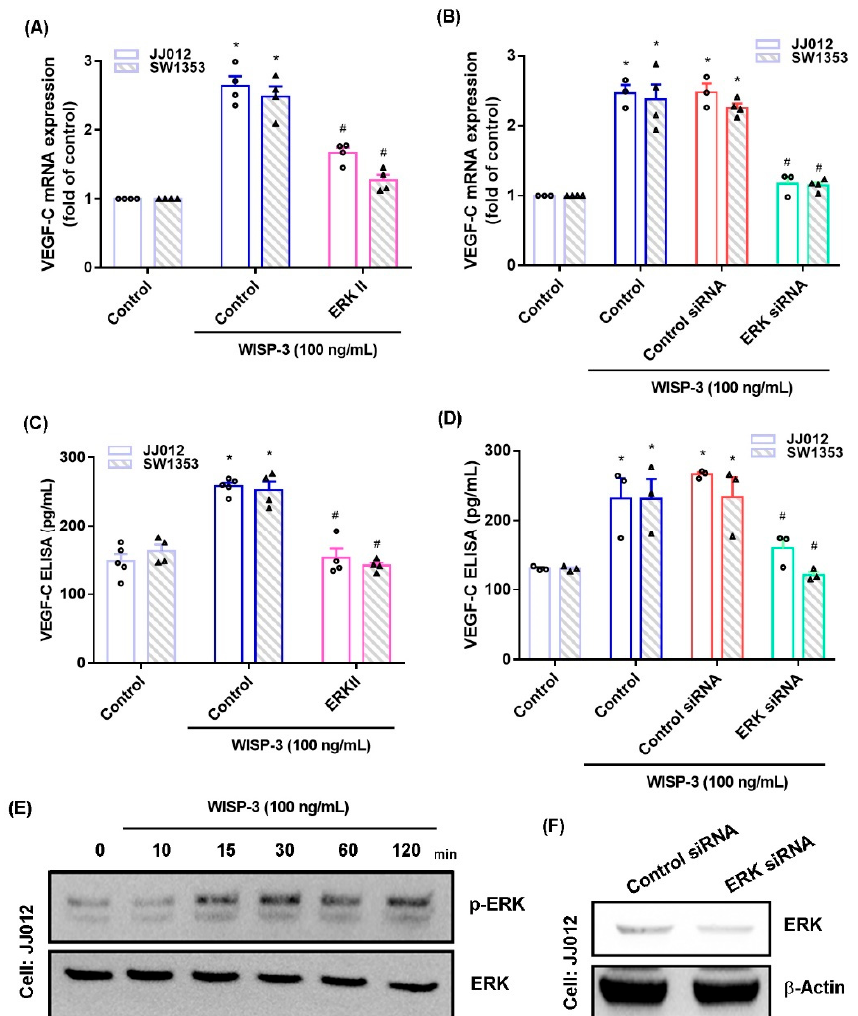
Figure 2. The ERK pathway controls WISP-3-induced VEGF-C production. ( A – D ) Cells were pretreated with a ERK inhibitor (ERK II) or transfected with an ERK siRNA, then stimulated with WISP-3. Levels of VEGF-C expression were examined by qPCR and ELISA. ( E ) JJ012 cells were incubated with WISP-3 for the indicated time intervals, and ERK phosphorylation was examined by Western blot. ( F ) JJ012 cells were transfected with ERK siRNA, and ERK expression was examined by Western blot. Quantitative results are expressed as the mean ± SD. All experiments were repeated 3 to 5 times (solid squares, solid dots, hollow circles and solid triangles). * p < 0.05 compared with the control group; # p < 0.05 compared with the WISP-3-treated group.